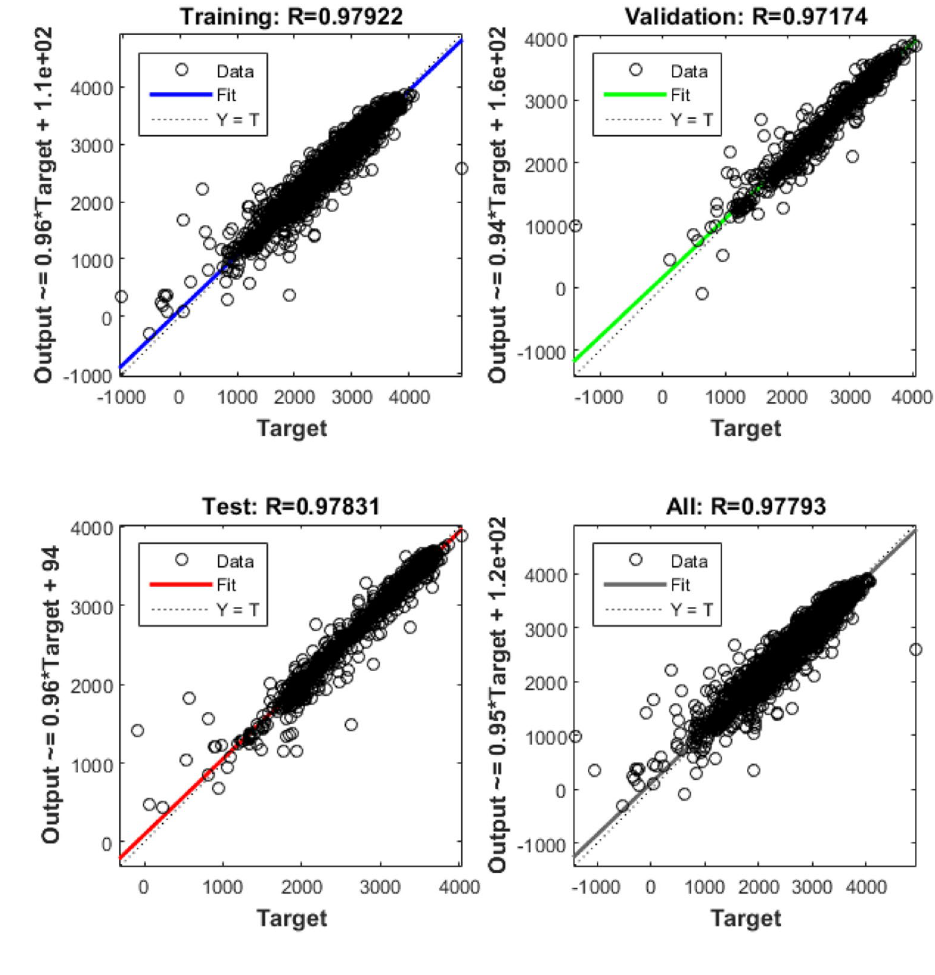
Fig. 20 Geomechanical model validation of Field X